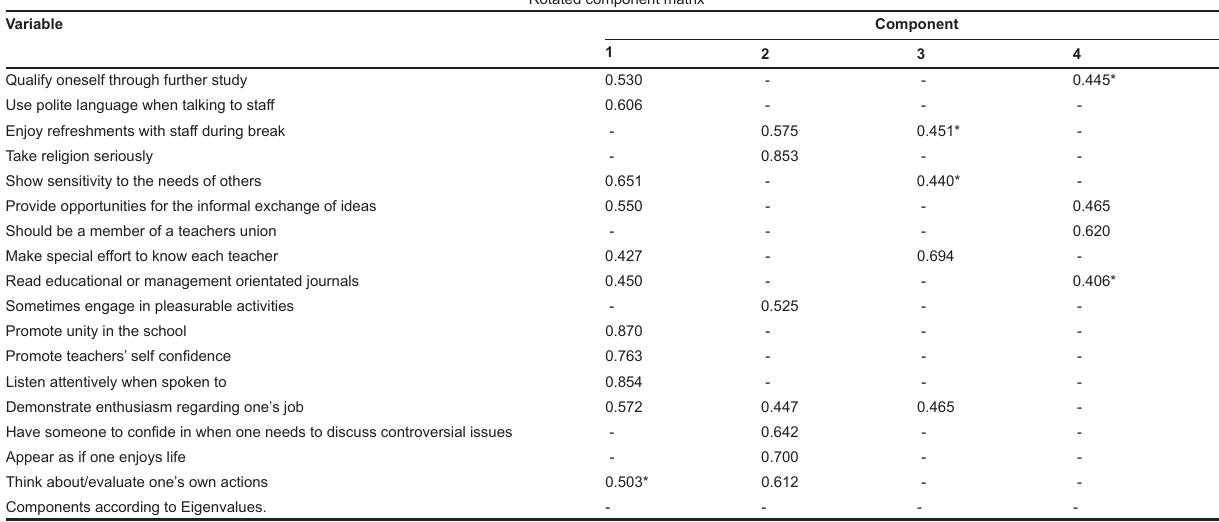
Table 4 Rotated component matrix